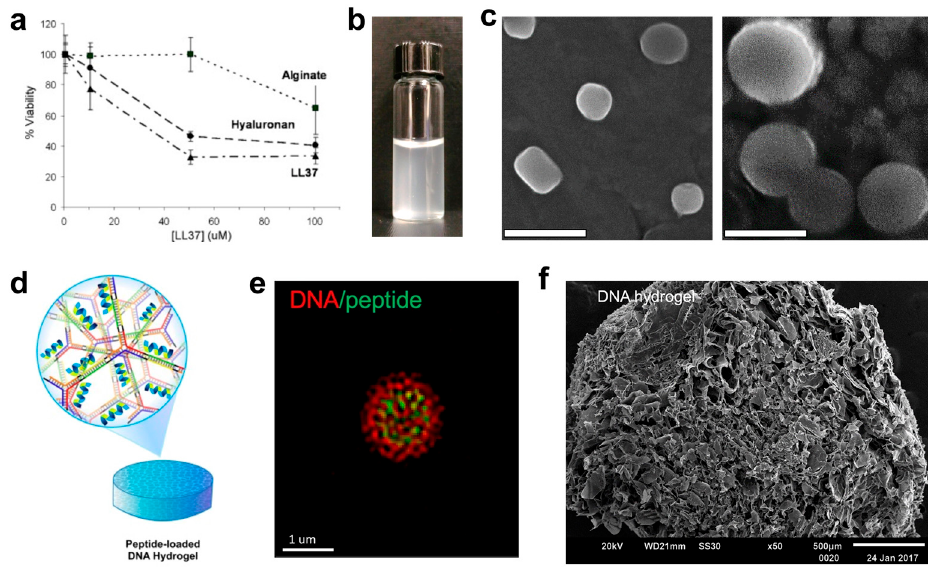
Figure 12. ( a ) Cytocompatibility of LL-37 and LL-37-carbohydrate complexes against human bone cells. Adapted from [169] with permission from Elsevier. ( b ) Solution turbidity of nanogels formed by electrostatic complexation by hyaluronic acid (HA) and poly-L-lysine (PLL). ( c ) SEM images of HA-PLL nanogels in water (left) and following swelling in physiologic medium (right). Scale bar = 500 nm. Adapted from [176] with permission from Elsevier. ( d ) Schematic detailing of Y-scaffolds and peptide loading strategy in antimicrobial hydrogels. ( e ) Confocal microscopy showing localization of nucleic acid matrix and encapsulated peptide. ( f ) SEM image of DNA-peptide matrix. Adapted from [188] with permission from